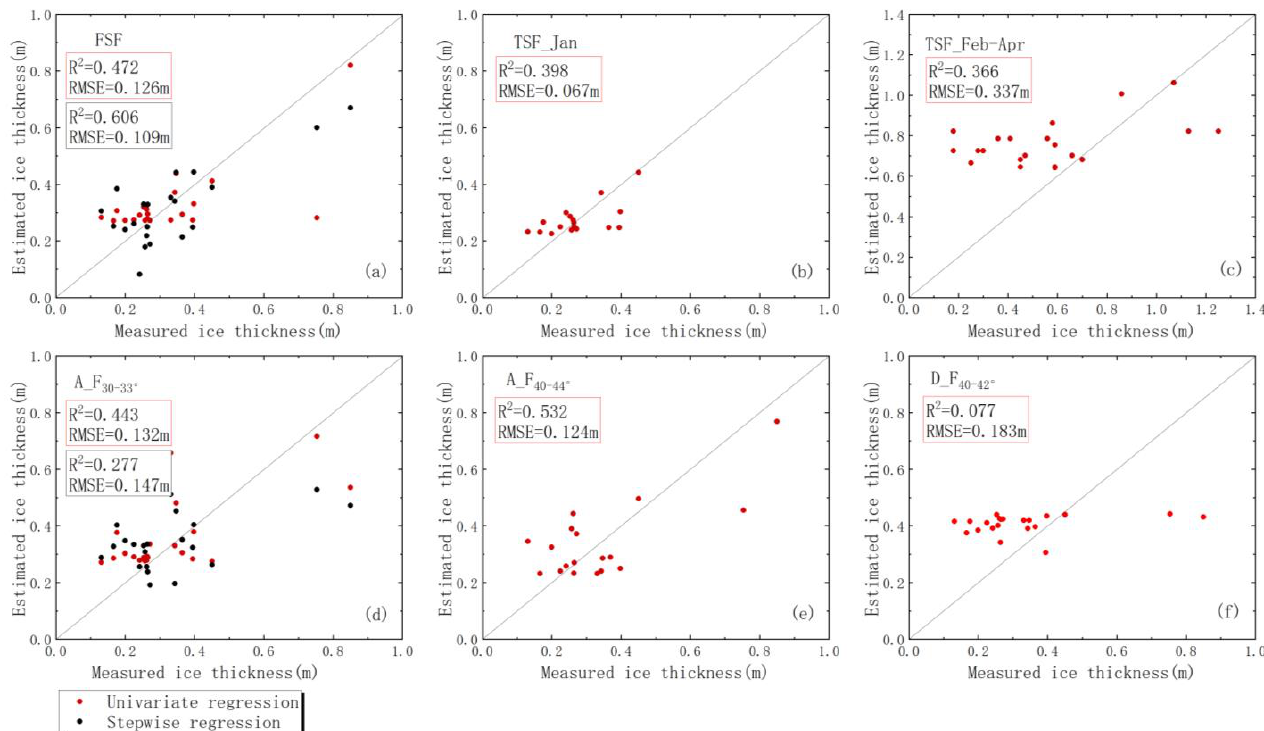
Figure 8. Comparison between the measured and simulated ice thicknesses in the Babao River (1:1 line), with the red dots indicating the univariate regression results and the black dots indicating the stepwise regression results. The red boxes indicate the univariate regression-simulated indicators, while the black boxes indicate the stepwise regression-simulated indicators. The panels are lettered a through f from left to right, top to bottom. ( a ) FSF; ( b ) TSF_Jan; ( c ) TSF_Feb–Apr; ( d ) A_F 30–33° ; ( e ) A_F 40–44° ; ( f ) D_F 40–42° .